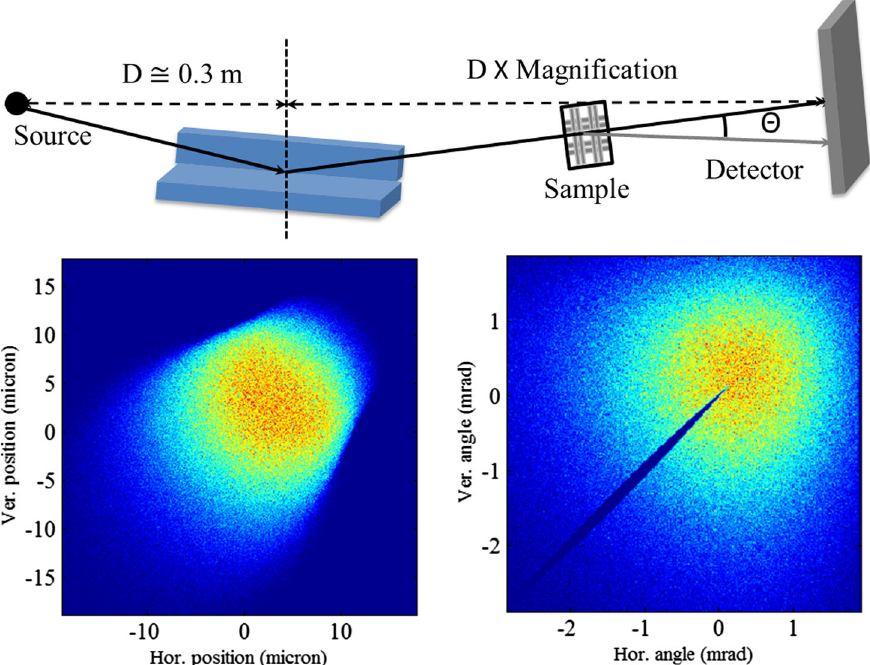
FIG. 9. Geometry and simulation results for focusing optics used in small angle scattering experiments. SAXS experiments are well suited to CXLS beam properties, taking advantage of the micron-sized source and higher flux available in a few percent bandwidth. In this arrangement the KB optic produces a factor of 3 magnification to produce a ∼ 100 μ m converging beam at the sample location on the way to a 10 μ m focus at the